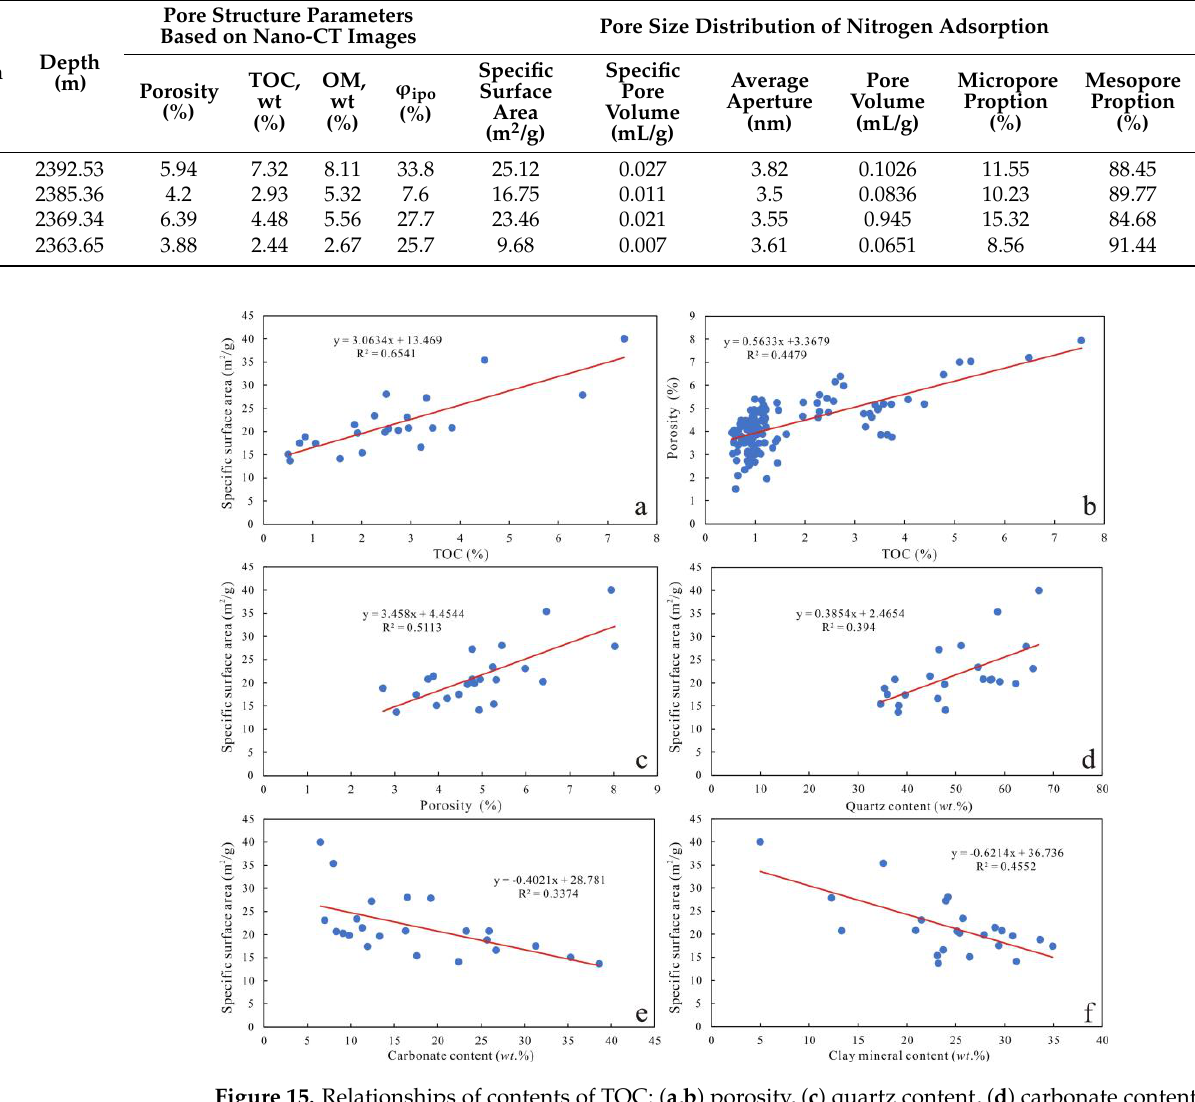
Table 3. Pore structure parameters of shale of the S 1 l 1 − 1 member.